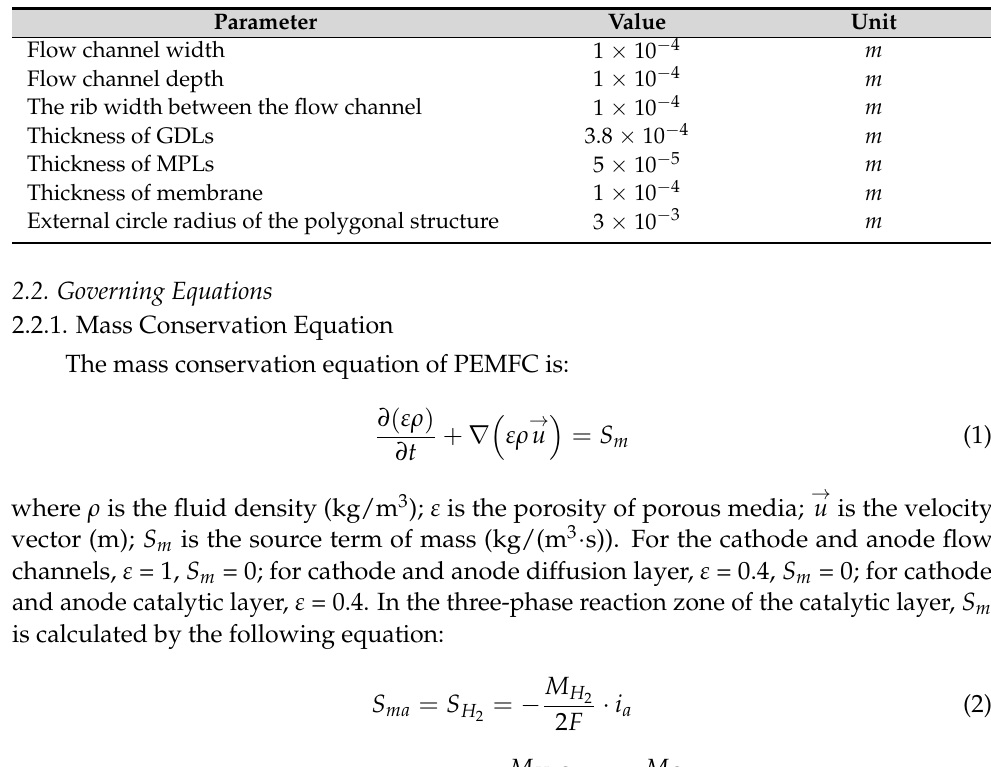
Figure 2. The PEMFC model established for the simulation. Table 2. Main geometrical parameters.